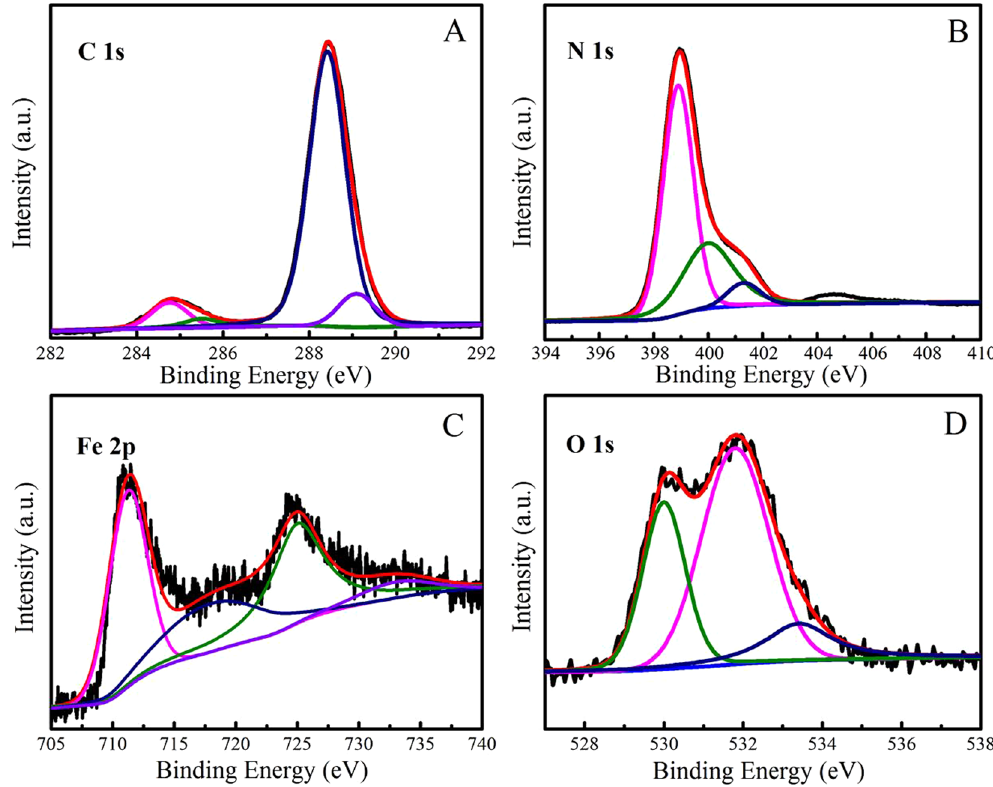
Figure 4. ( A ) and ( B ) high resolution spectra of C 1s and N 1s for a-FeOOH/CNNS-800 composite; ( C ) and ( D ) high resolution spectra of Fe 2p and O 1s for a-FeOOH/CNNS-800 composite.